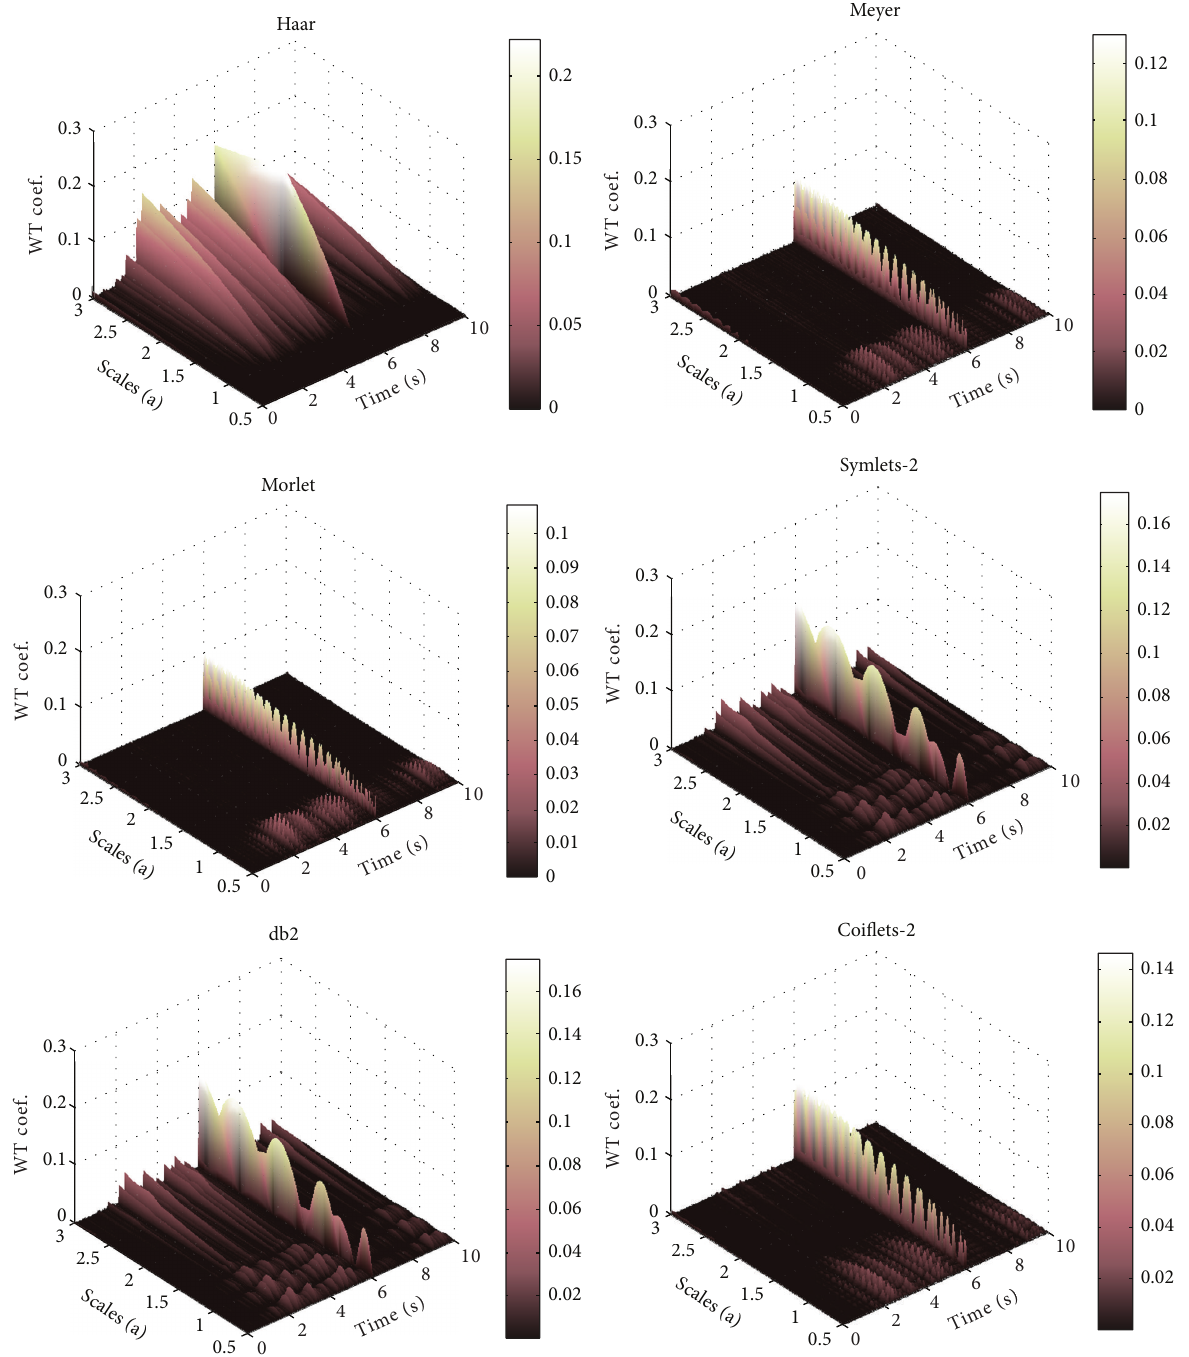
Figure 10: Detection results under seismic excitation using different mother